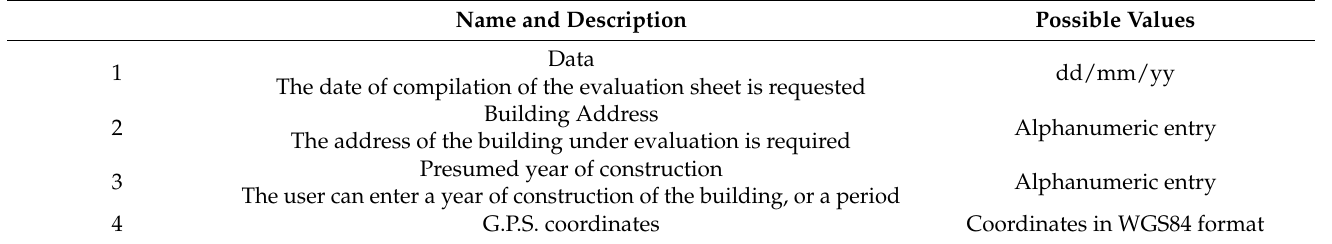
Table A1. General data.